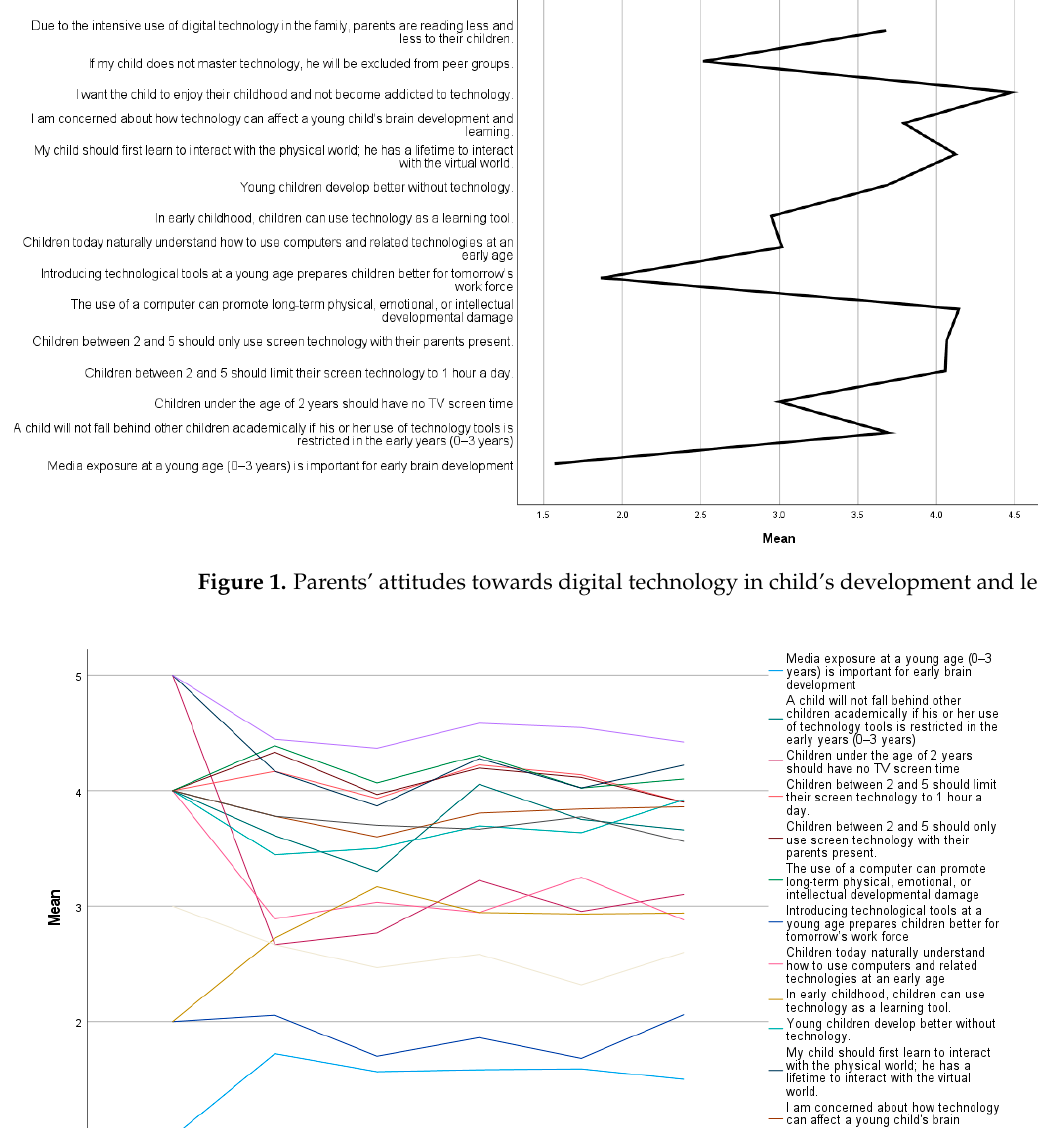
Figure 2. Parents’ attitudes towards digital technology in child’s development and learning accord- ing to child’s